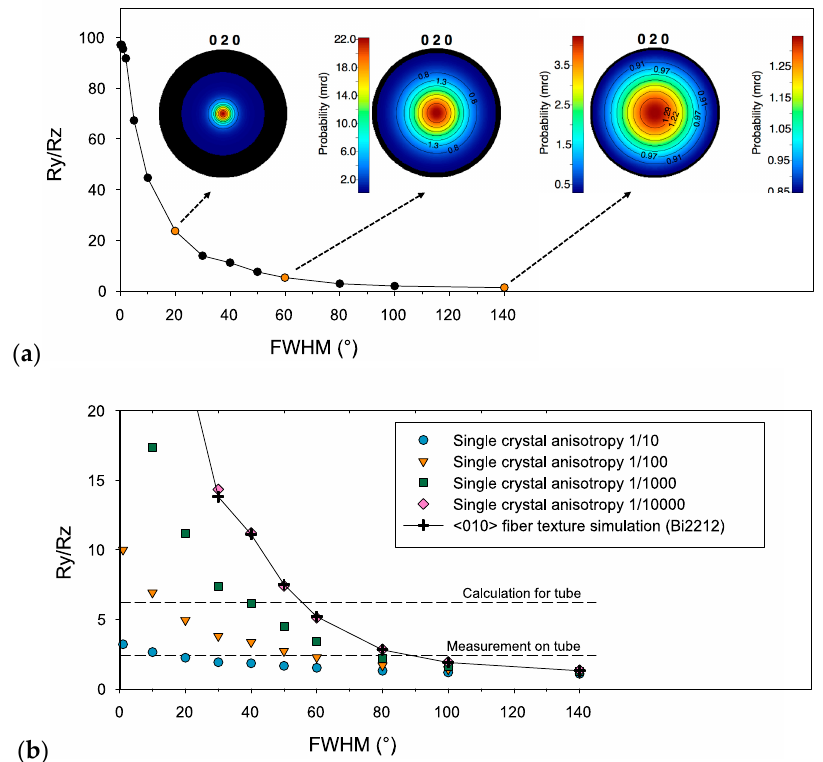
Figure 7. The anisotropic resistivity ratio of the Bi-2212 phase for ( a ) a simulated fiber texture characterized by a ρ 33 / ρ 11 = 10 4 anisotropy with varying Gaussian full-widths and ( b ) simulated fiber textures with varying anisotropy and Gaussian full-widths and their comparison to melt-cast tube. FWHM: full width at half maximum.